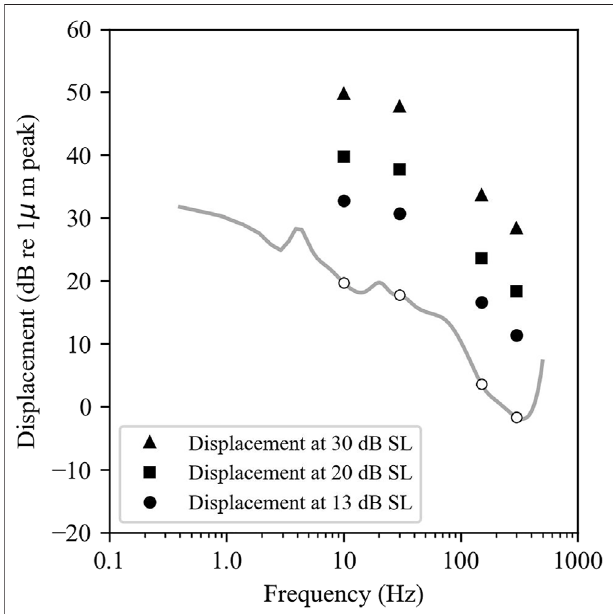
FIGURE 4 | Results of sensitivity index d ′ from pairwise discrimination in Experiment 1 for the two participants: P01 in the top panel, and P02 in the bottom panel. The horizontal line indicates d ′ = 1.0.